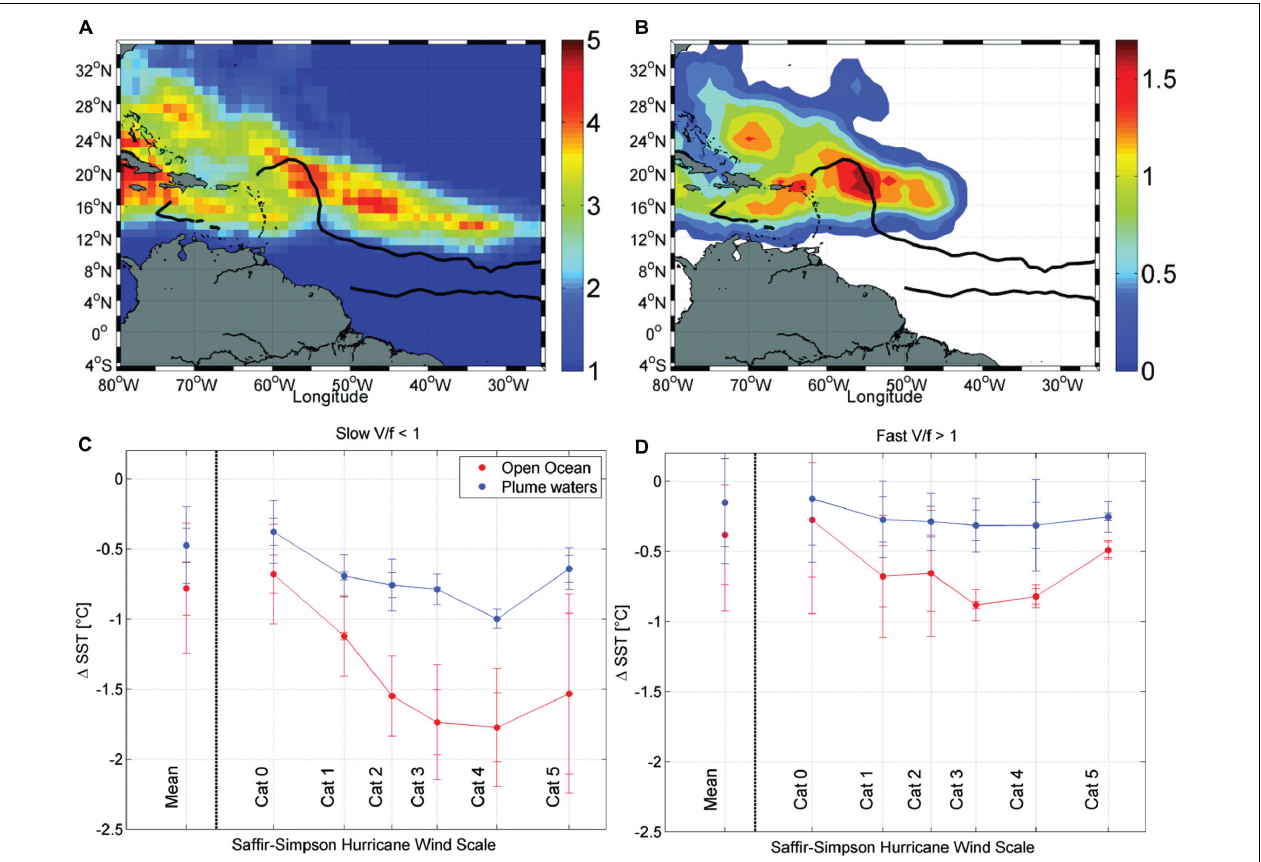
FIGURE 5 | The number of 1950–2010 “best track” TCs per 1 ◦ box (smoothed by a 3 ◦ × 3 ◦ block average) (A) that evolve as categories 4 and 5 somewhere along their path and (B) that intensified locally to categories 4 and 5. The black curve shows the historical extent of the Amazon–Orinoco river plume during the hurricane peak season (August to October). (C,D) Mean sea surface cooling induced by North-Atlantic hurricanes as a function of the Saffir-Simpson wind scale, with error bars showing the 90 and 95% significance levels. Responses estimated over open ocean waters (red dots) are distinguished from those evaluated within the historical plume region (blue dots). (C) Slow-moving (or low latitude) tropical cyclones with V/f < 1 ( V is translation speed and f is Coriolis parameter), (D) fast moving (or high-latitude) storms with V/f > 1. Adapted from Reul et al.